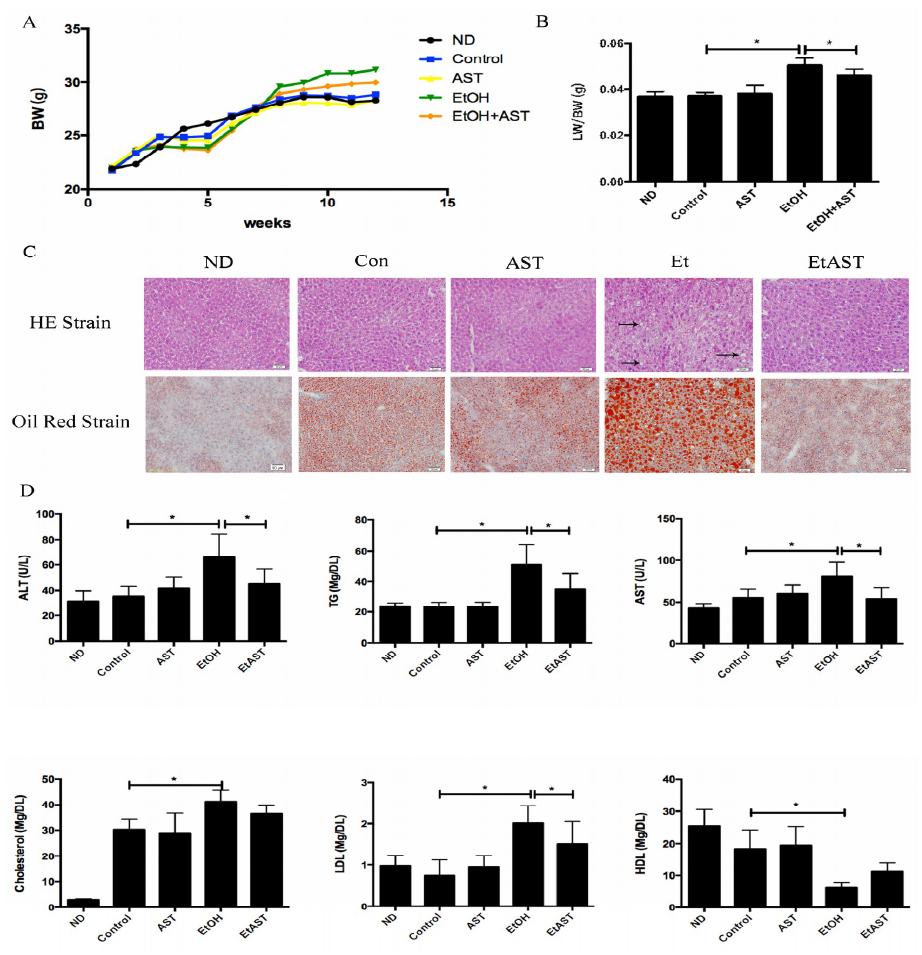
Figure 1. Effect of astaxanthin on body weight, pathological morphology, and serum markers involved in liver injury in ethanol diet-fed mice. C57BL/6J mice were fed the Lieber–DeCarli liquid diet containing 5% ethanol for 12 weeks ad libitum with or without 50 mg kg −1 of astaxanthin. Body weight was measured once a week ( A ). The liver index was represented by calculating liver weight/body weight ( B ). The statues of hepatic steatosis were checked by hematoxylin and eosin (H&E) staining and hepatic lipid accumulation was detected by Oil red O staining. The symbol → plays a indicate role to identify the fat vacuoles ( C ). The serum markers of liver injury were determined by the enzyme activities of alanine aminotransferase (ALT) and aspartate aminotransferase (AST). Lipid accumulation in the liver was reflected by the levels of hepatic markers, including plasma triacylglycerol (TG), low-density lipoprotein (LDL), high-density lipoprotein (HDL), and total cholesterol (TC) ( D ). ND: normal diet; Con: high-fat diet with 35% of total calories from fat; AST: high-fat diet + astaxanthin; Et: Lieber–DeCarli liquid ethanol diet with 35% of total calories from fat; EtAST: Lieber–DeCarli liquid ethanol diet with 35% of total calories from fat + astaxanthin. All values represent means ± SD. * p < 0.05 represents significant differences in each group compared with the ethanol (Et) group by ANOVA analysis.